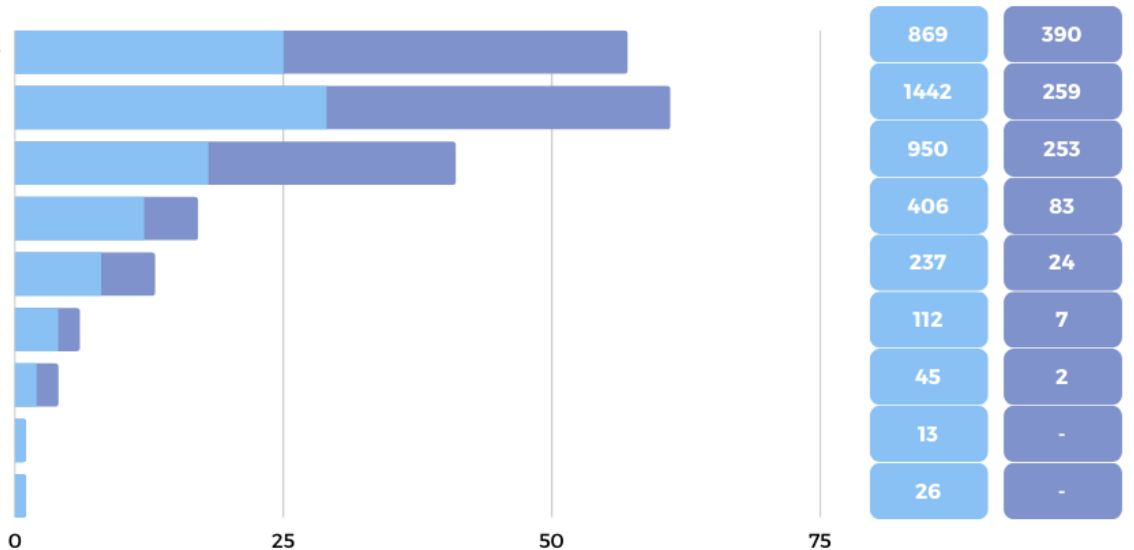
Figure 6. Distribution of collaboration in the knowledge area. Source: Authors’ own data.